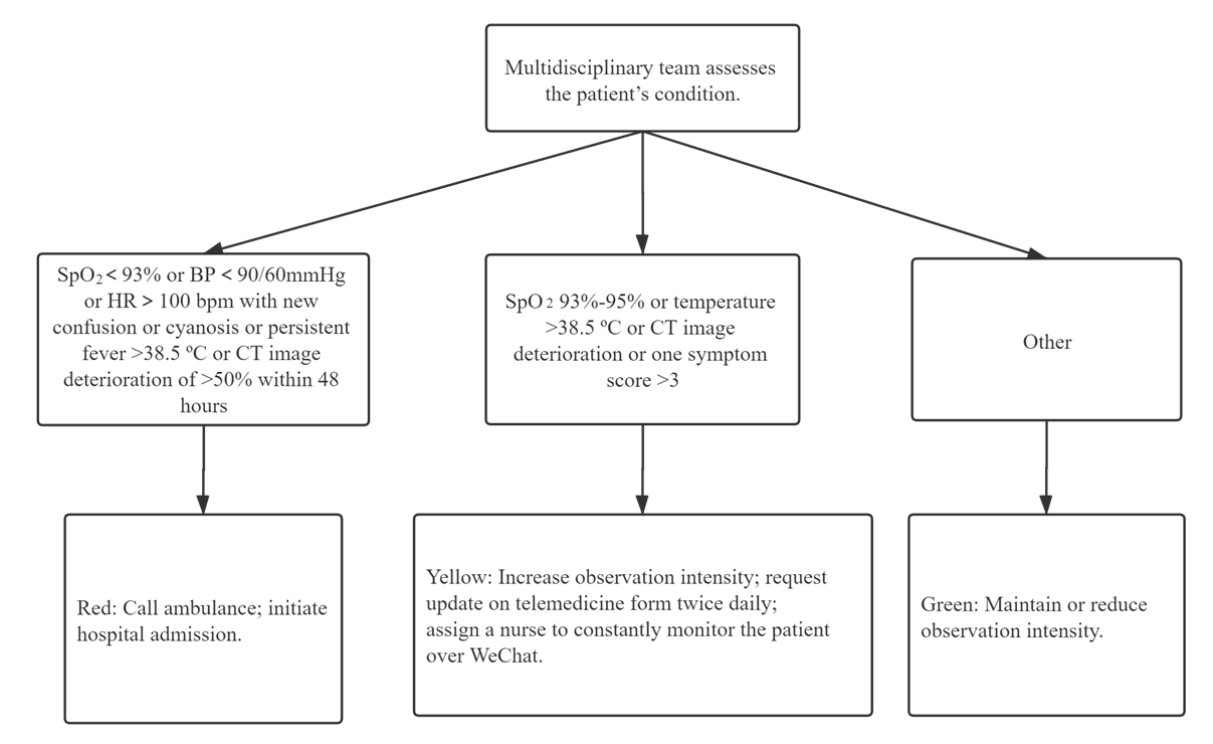
Figure 2. Decision tree of patient treatment for MDT based on patients’condition updates via the eCounseling system. ºC: degrees Celsius; BP: blood